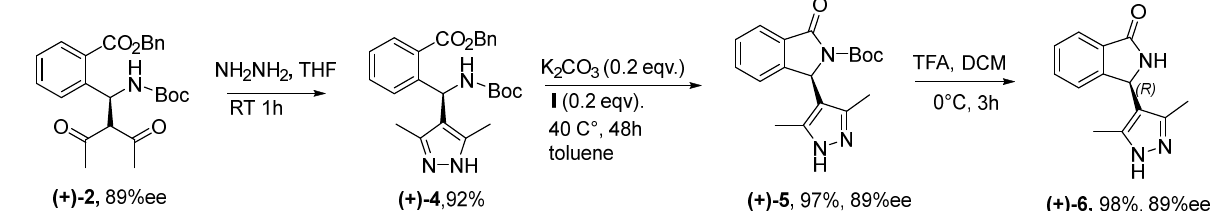
Scheme 2. Asymmetric synthesis of isoindolinone-pyrazole hybrid.